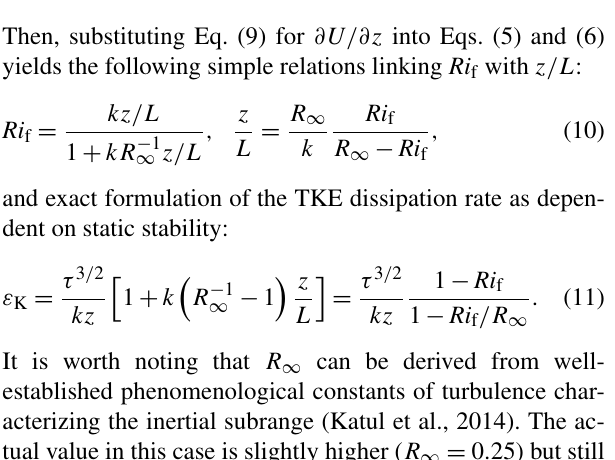
In these figures DNS data are shown by bold coloured dots, and atmospheric data by light-grey symbols (Kadantsev et al., 2019). Figure 2 shows flux Richardson number, Ri f = in Couette flow; or versus z/L in the atmospheric surface layer. The black curve is plotted after Eq. (10) taking the conventional value of the von Kármán constant, k = 0 . 4, and our estimate of the maximal flux Richardson number, R ∞ = 0 . 2, resulting from the best fit of Eq. (10) to DNS data. Notably, total (turbulent + molecular) fluxes of momentum, τ , and potential temperature, F z , in Couette flow are constant across the flow which assures a very certain specification of Ri f and L , and makes our DNS most suitable for calibrating the theory. We recall that Eqs. (10) and (11) are relevant to the well-developed turbulence regime where molecular transports are negligible, so that turbulent fluxes practically coincide with total fluxes. In our DNS this is true, except for the narrow transition layers dominated by molecular transport near the lower and upper walls: 0 < e z < 50 ν/τ 1 / 2 . Data from these layers are indicated by dark-grey points . The light-grey symbols show atmospheric data from the following sources: research observatory Tiksi in eastern Siberia near the Arctic Ocean coast (Grachev et al., 2018), offshore oceanographic platform in the Black Sea (Repina et al., 2009); and acoustic soundings over arid steppe in the Republic of Kalmykia in Southern Russia (Vazaeva et al., 2017). In spite of inevitable heterogeneity, non-stationarity, and other side effects, atmospheric data correlate quite well with DNS data. Figure 3 shows dimensionless dissipation rate, ε K z/τ 3 / 2 , versus z/L after Eq. (11) and atmospheric data; and ε K e z/τ 3 / 2 versus e z/L after DNS of Couette flow. All notations are the same as in Fig. 2. The theoretical curve plotted after Eq.